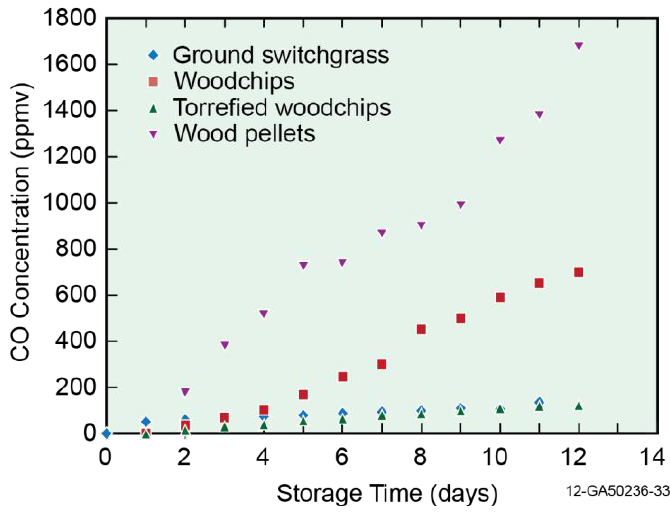
Figure 2. CO concentration at 20 °C storage temperature.